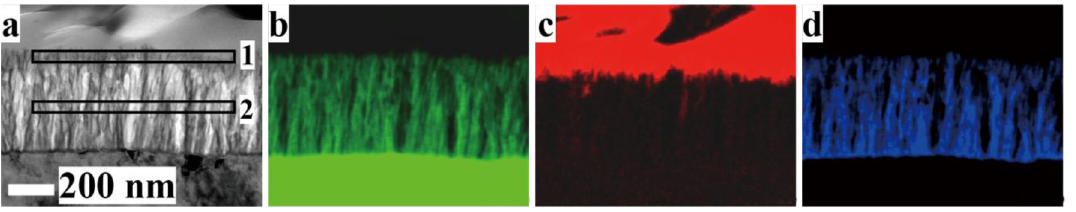
Fig. 3. Cross-sectional views of PPS/5052 joint interface with NMT2 surface treatment. (a) STEM-BF image and (b) – (d) EDX elemental maps of Al, S and O, respectively.